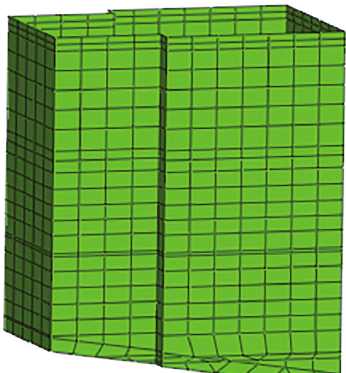
Figure 14: Schematic diagram of the ground connection wall (the depth into the rock is